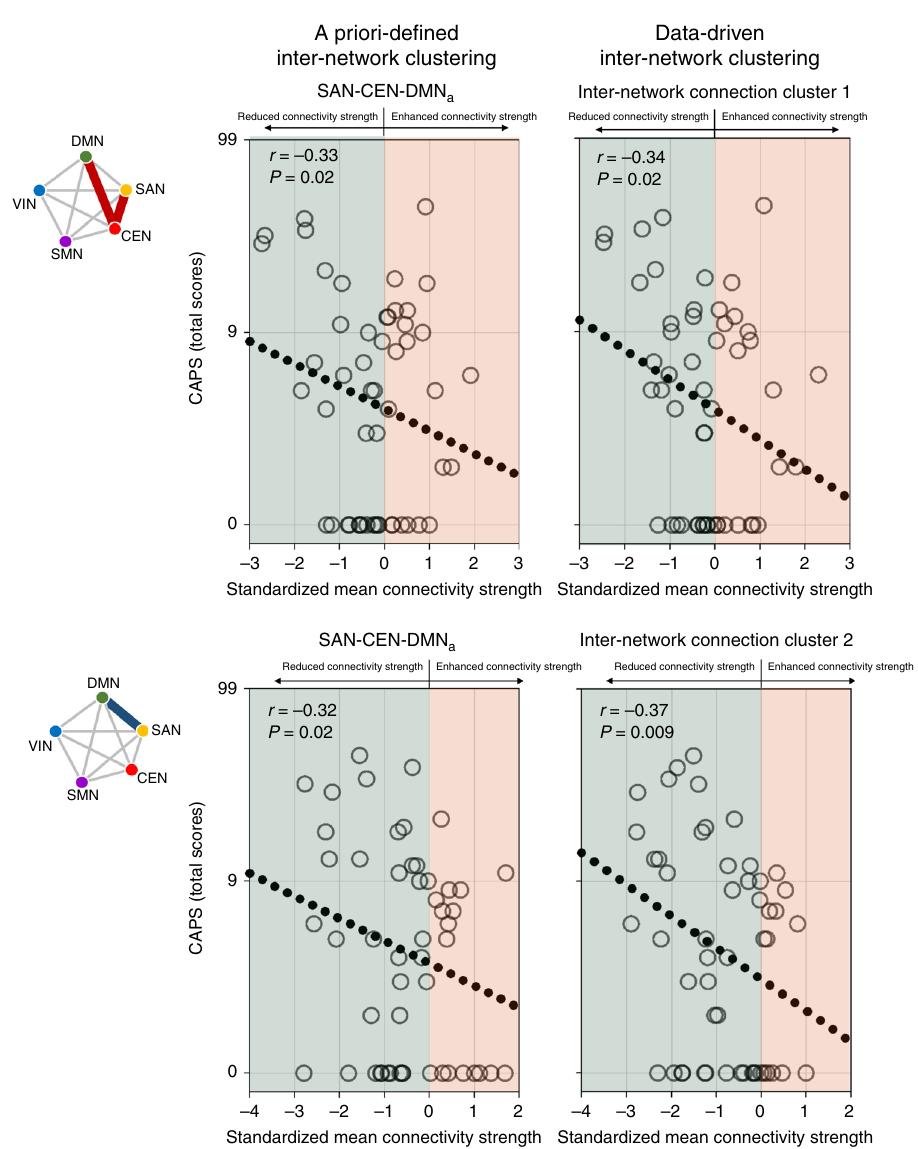
Fig. 6 Associations between altered inter-network connectivity strength and posttraumatic stress (PTS) symptom severity. Greater functional coupling among the SAN – CEN – DMN a ( r = − 0.33, P = 0.02) or inter-network connection cluster 1 ( r = − 0.34, P = 0.02) was associated with lower PTS